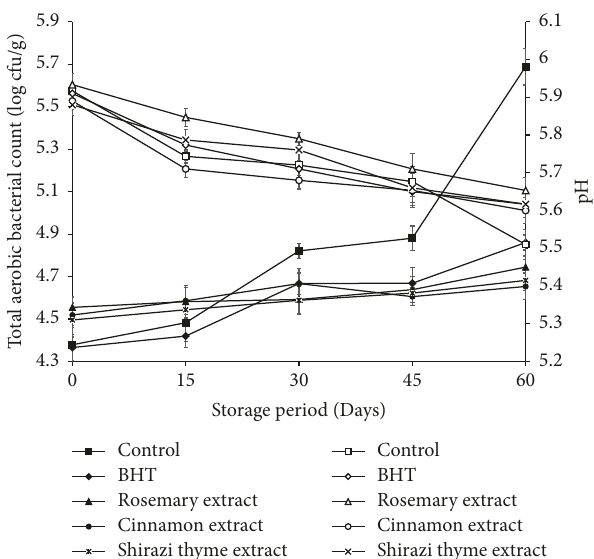
Figure 3: Total aerobic bacterial count (logcfu / g) (solid symbols) and pH value (open symbols) of different beef burger formulations as a function of storage